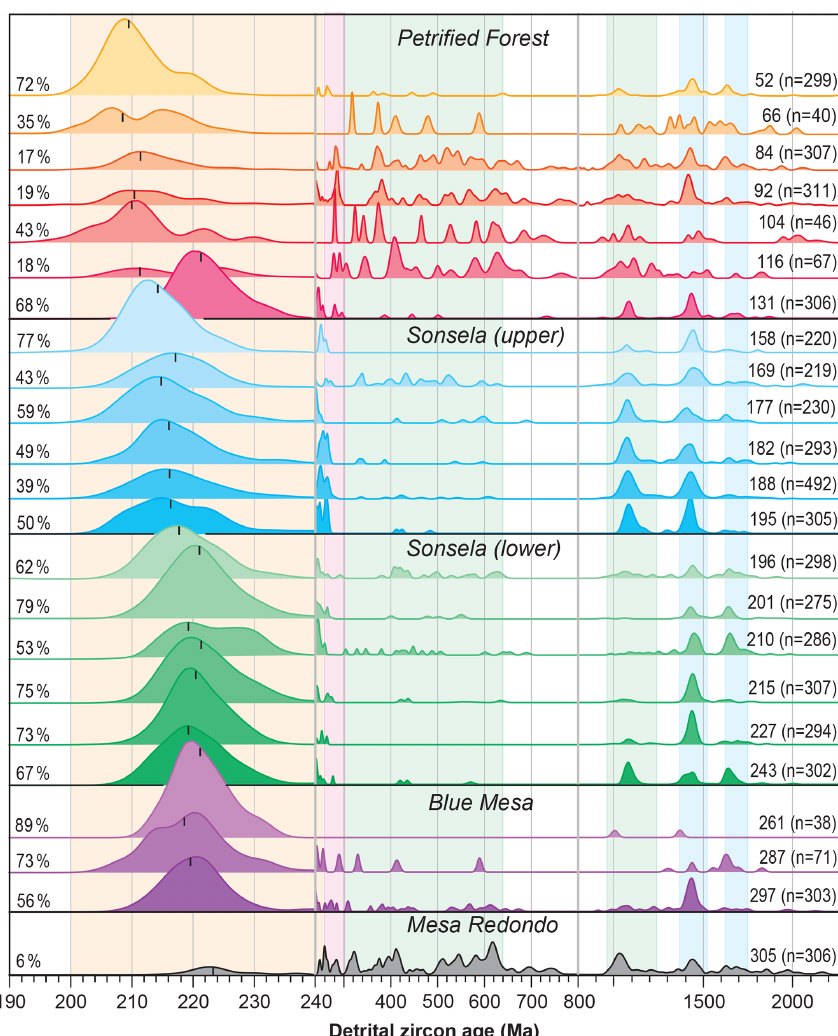
Figure 7. Normalized probability density plots of detrital zircon ages from 23 samples from the Mesa Redondo, Blue Mesa, Sonsela, and Petrified Forest members of the Chinle Formation. Numbers of constituent analyses are shown for each sample. Age distributions older than 240Ma are exaggerated by a factor of 10. Black tick marks indicate the interpreted maximum depositional ages for each sample (from Table S6). Source regions are interpreted to include local basement rocks (blue bands), the Ouachita orogen (green bands), the East Mexico arc (red band), and the Late Permian–Triassic arc built along the Cordilleran margin (orange band). The percent of all grains that are < 240Ma in age is shown for each sample on the